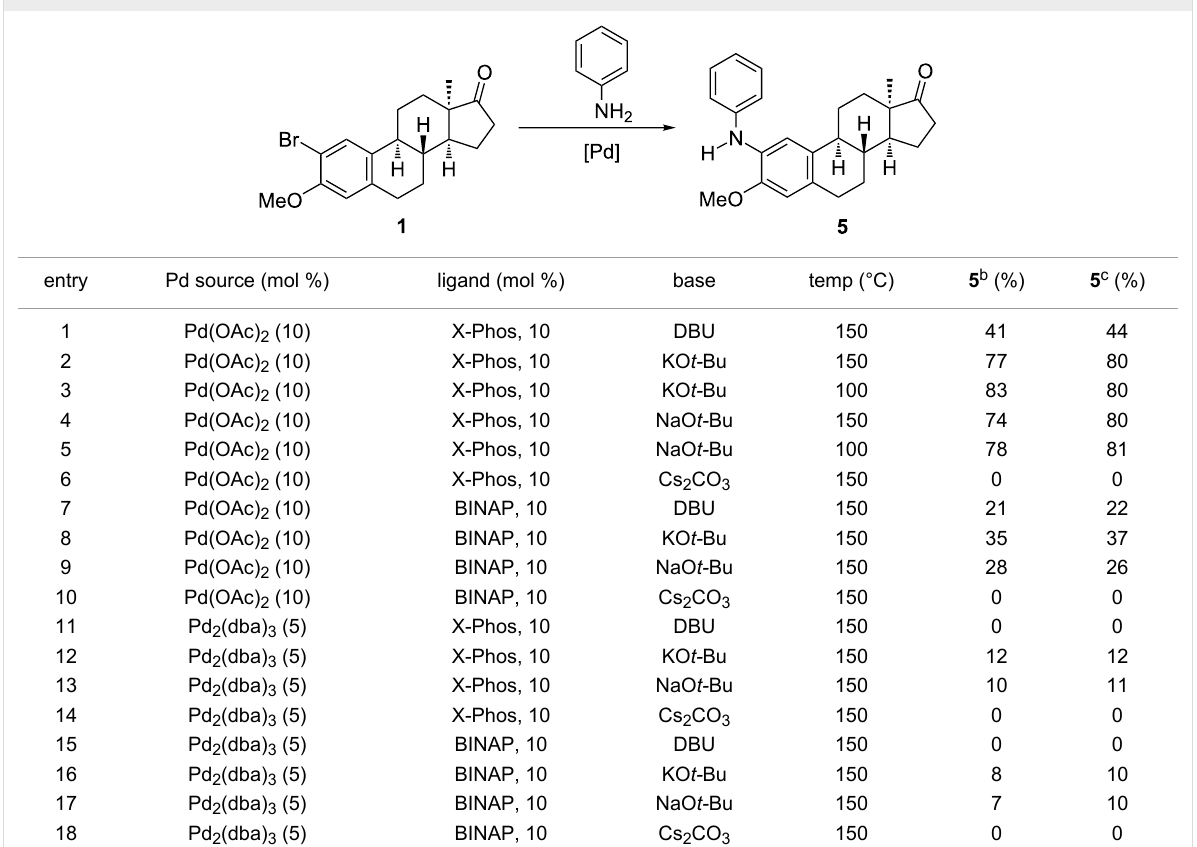
Table 1: Effect of the reaction conditions on the Pd-catalyzed amination of 2-bromo-13 α -estrone 3-methyl ether ( 1 ) with aniline in toluene a